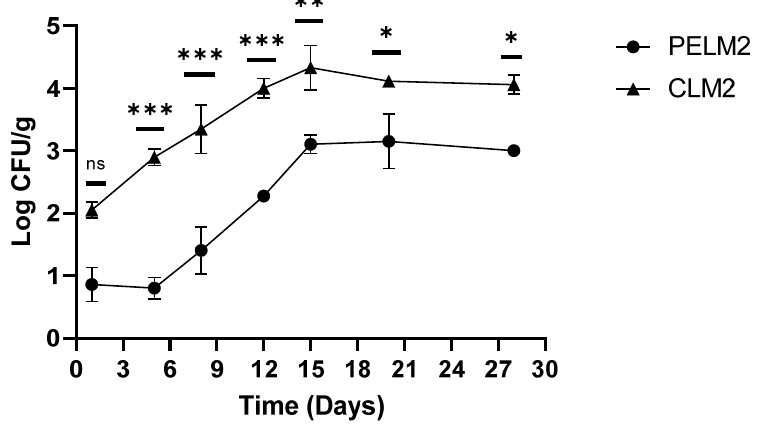
Figure 3. Trend of L. monocytogenes during shelf-life of ham cooked with (PELM2) and without (CLM2) plant extract. p -values of * < 0.05, ** p < 0.01, *** p < 0.001 and **** p < 0.0001 were considered significant by t-test and ANOVA. ns means not significant.